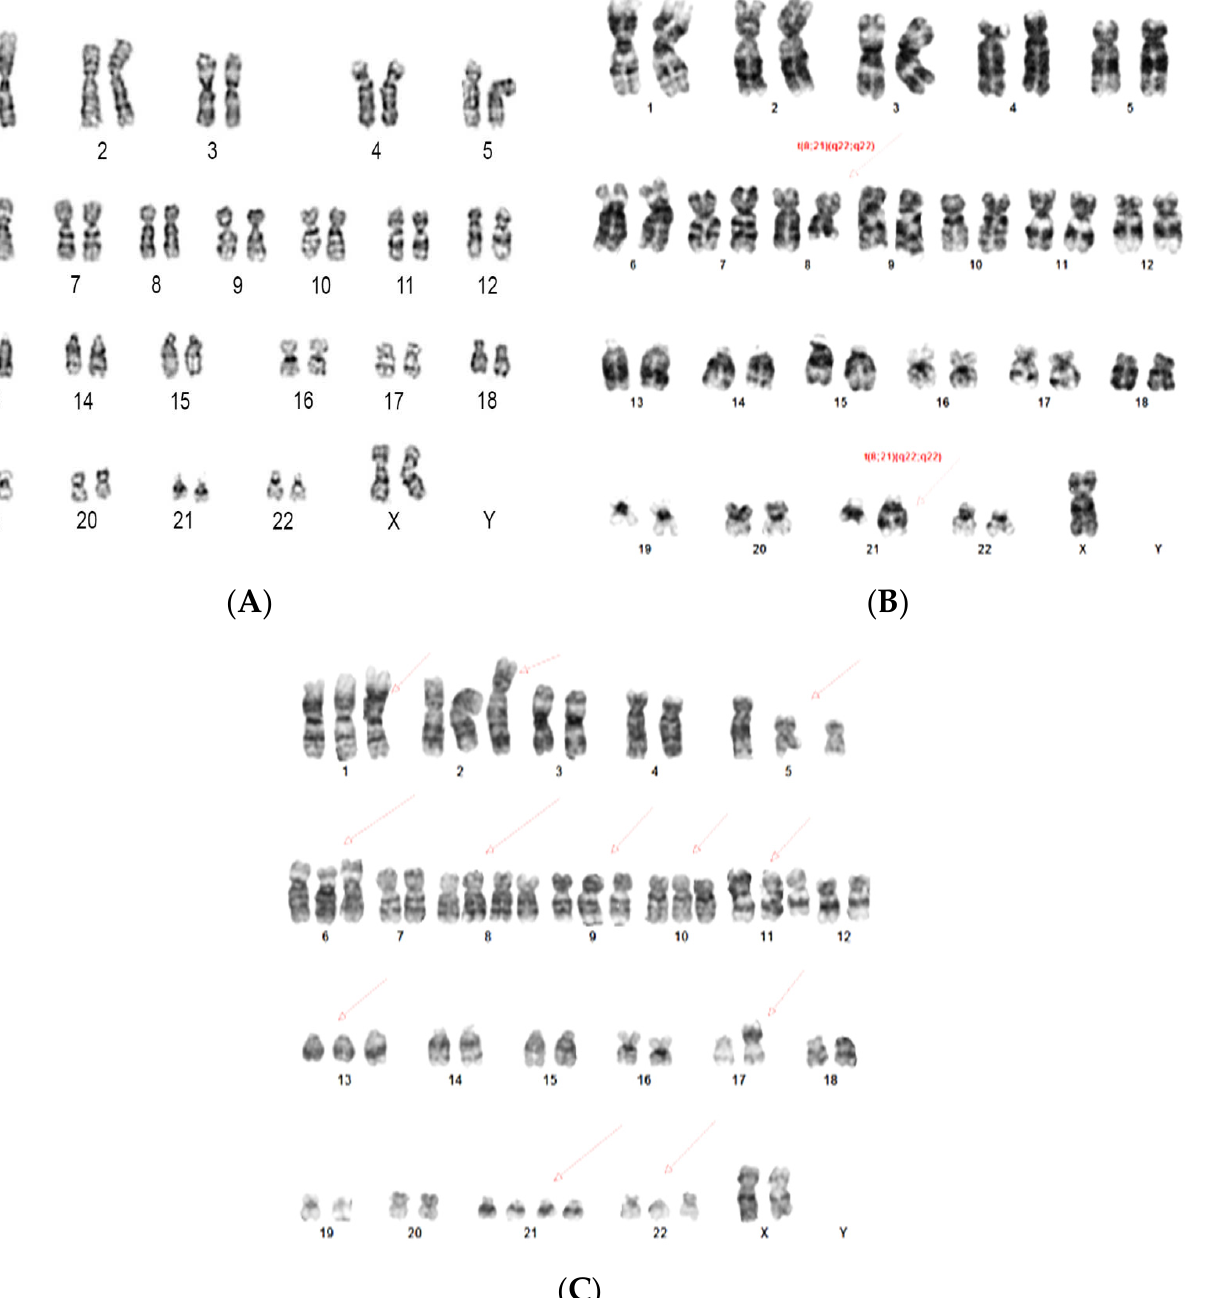
Figure 1. Demonstrated cytogenetic result. ( A ) represented AML female with normal karyotype. ( B ) ALL patient with single chromosome abnormality, 46, XY, t (8; 21) (q22; q22). ( C ) MDS patient with complex karyotype, 65-58, XX, +1, +2, der (2) t (2;5) (q12; q37), +5, +6, +8, +9, +10, +11, der (17) t (12;17) (p10; p10), +13, del (13) (q21), +21, +21 [cp50]). Table 3. FISH result in relation with the clinical diagnosis and cytogenetic finding. Diagnosis Cytogenetic FISH NHL (1), ALL (5), AML (8) Normal karyotype (14)